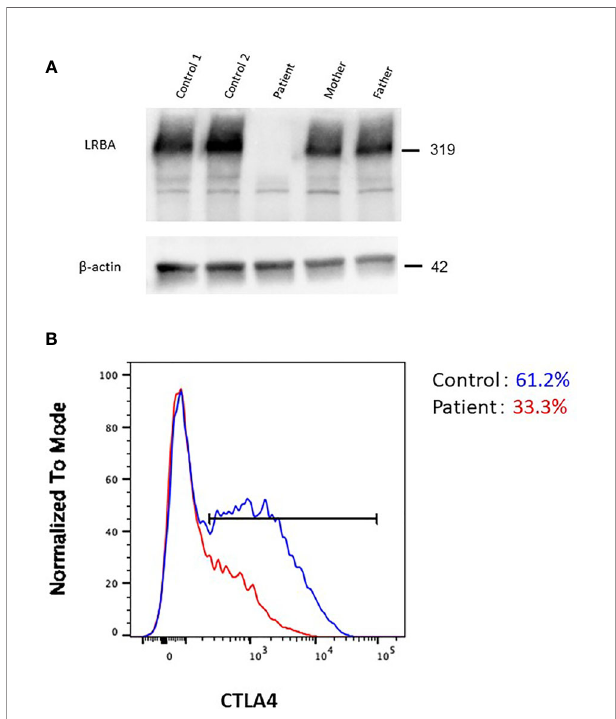
FIGURE 4 | Effect of the pathogenic LRBA mutations on the protein level. (A) Immunoblotting of LRBA in T-cells from the patient (Pt), her heterozygous mother, her heterozygous father, and two independent healthy controls. The results are representative of those of two independent experiments. (B) Flow cytometric analysis of CTLA4 expression in CD4 + FOXP3 + T-cells from a healthy control (blue line) and the patient (red